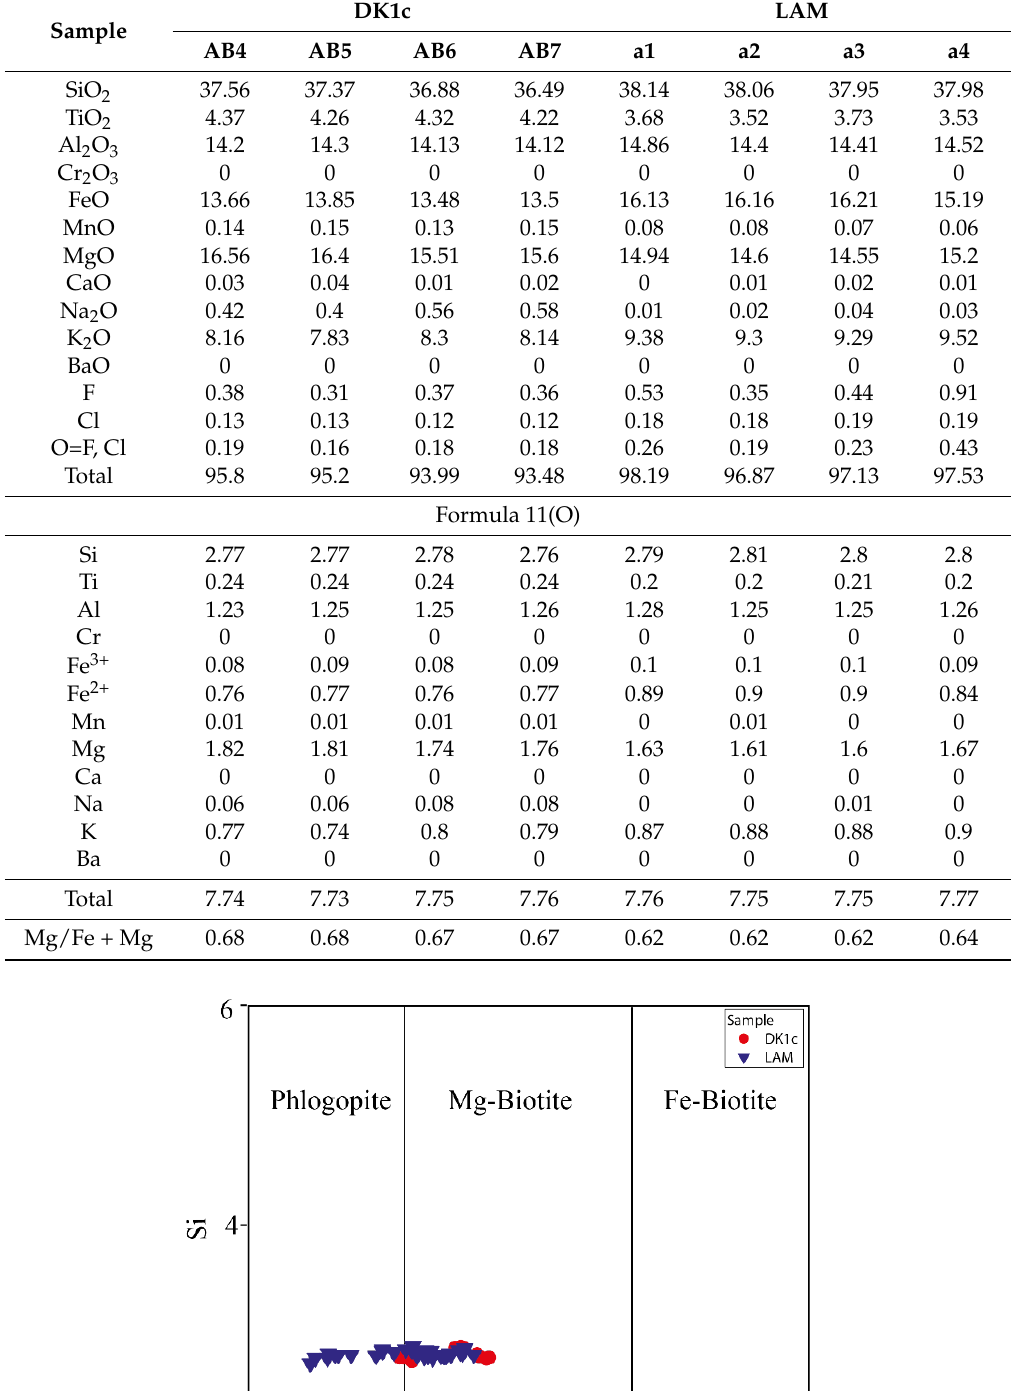
Table 3. Representative microprobe analysis of biotite. Cation calculation is based on 11 oxygen.